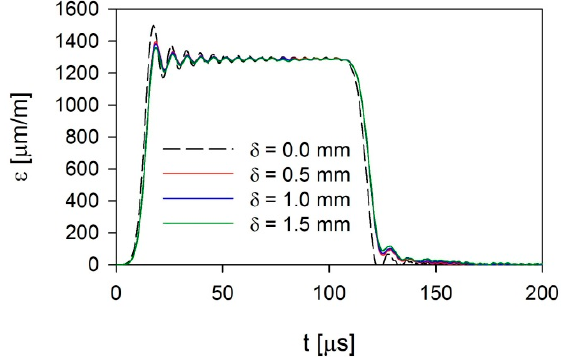
Figure 12. Incident-disturbed pulses for SHPB using a rounded striker for an imperfection in the form of neutral axis offset δ .